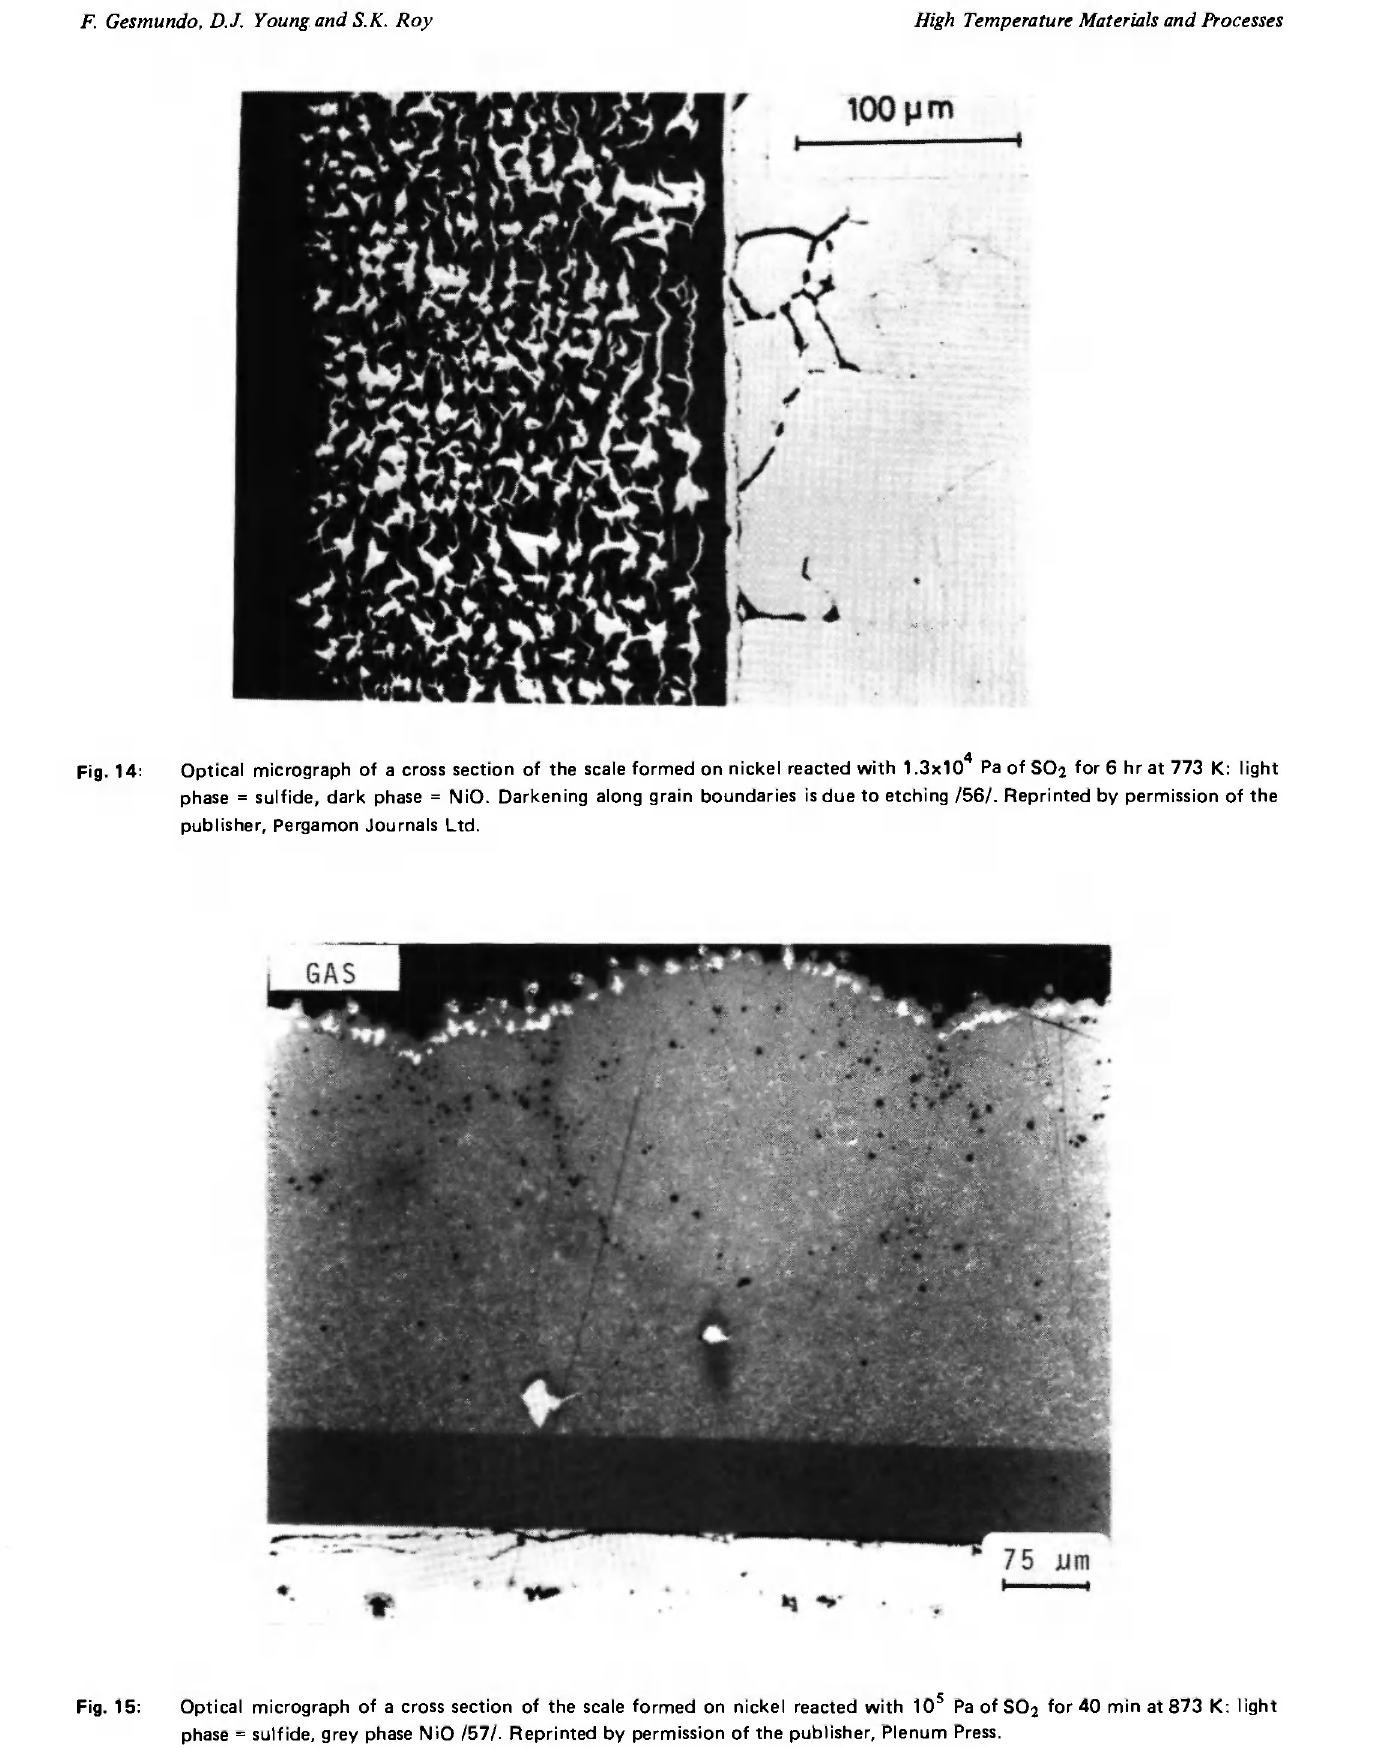
Fig. 15: Optical micrograph of a cross section of the scale formed on nickel reacted with 10 s Pa of SO2 for 40 min at 873 K: light phase = sulfide, grey phase NiO /57/. Reprinted by permission of the publisher, Plenum